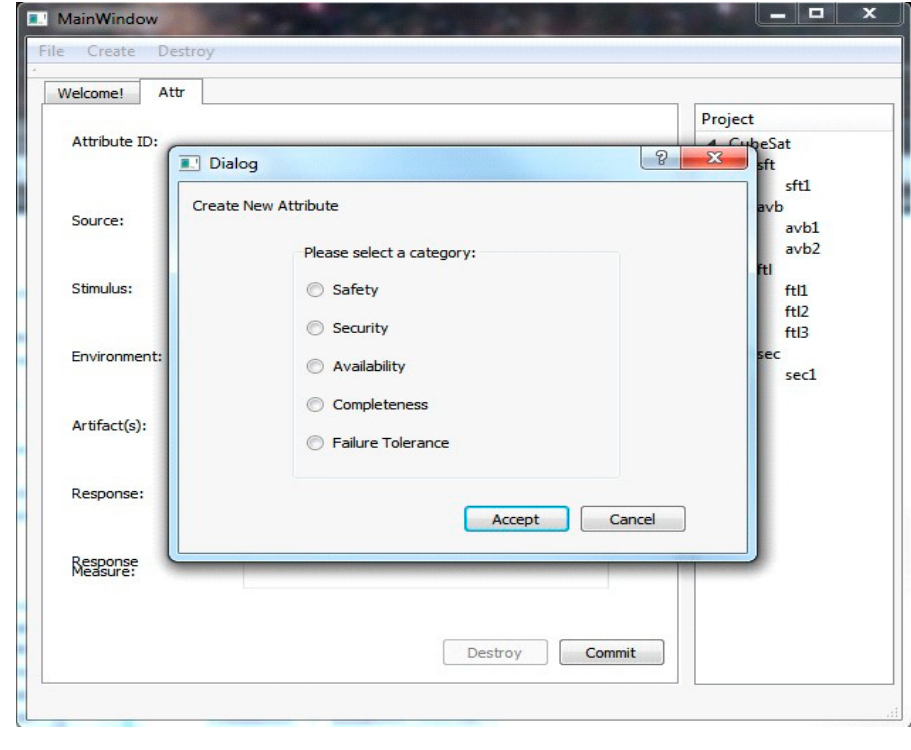
Figure 4. The quality attribute categories [25].